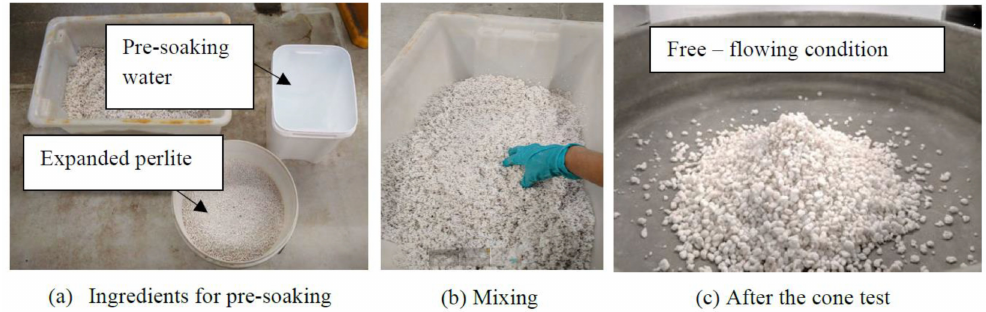
Figure 6. Achieving SSD condition of expanded